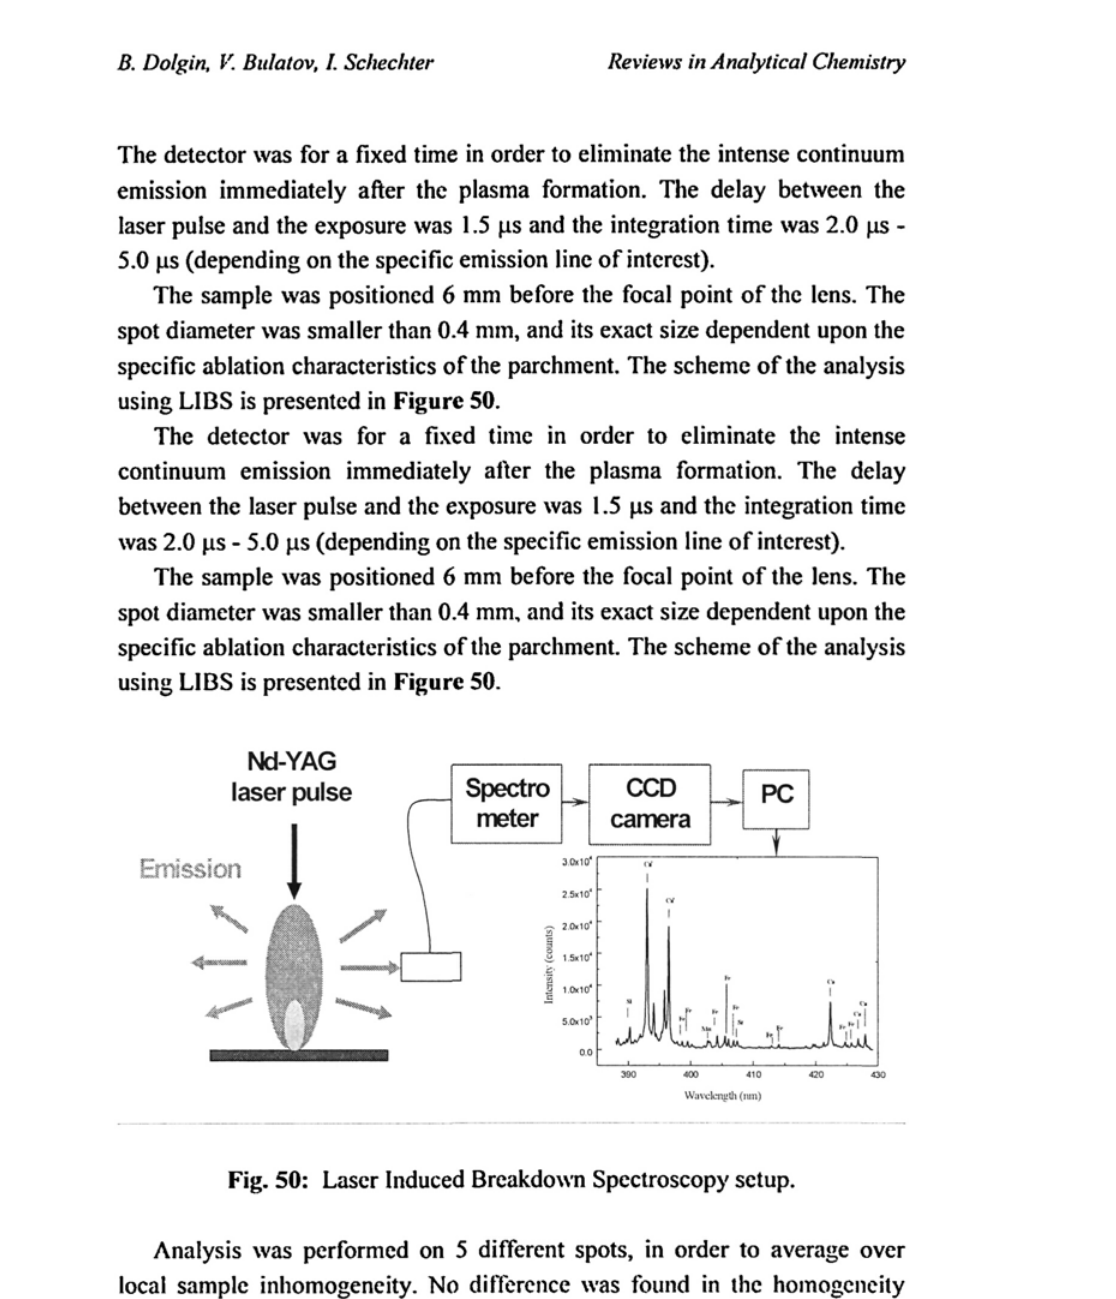
Fig. 50: Laser Induced Breakdown Spectroscopy